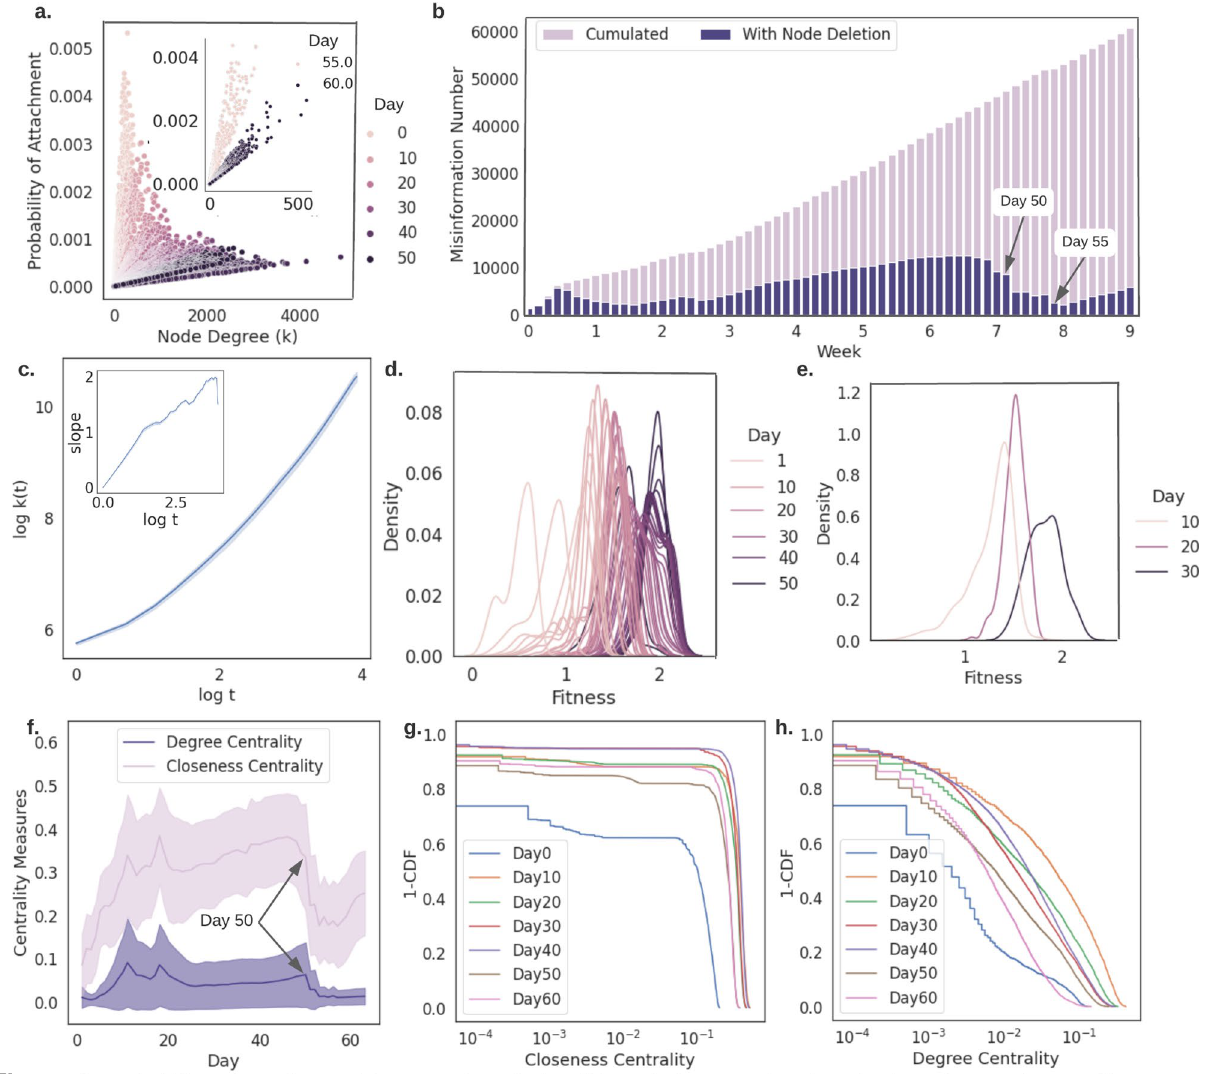
Figure 4. Probability of attachment ( a ), network evolution ( b ), node fitness estimations ( c-e ), and network centrality measures ( f-h ) of misinformation networks with deletion mechanism. ( a ) The probability of attachment is linearly correlated with the node degree. From day 0 to day 50, the probability of attachment for nodes with same degrees is decreasing. This observation shows that the rich get richer effect becomes weaker. Then the probability of attachment from day 55 appears to be similar as in day 0 to 10. ( b ) Misinformation network size (node) evolution comparison. Different from classical network expansion method (as shown in light purple bars), our realistic network construction method with node deletion mechanism appears to be sensitive to public attention/topic shifting. ( c ) The evolution of 158 surviving nodes S [ 0,50 ] ’s accumulated degrees, k ( t ) over time. Node fitness is approximated as the slope and it increases from day 0 until day 49 as shown in in-plot. This finding is distinct from the frequently used time-invariant fitness assumption in complex network evolution models. Hence, we further inspect the fitness (growth exponent) distribution of S [ 0,50 ] as shown in ( d ). These distributions do not have heavy tail property, which indicates that there is no clear sign of fit get richer phenomenon. Moreover, to compare with fitness distribution we observed in Fig. 3 more clearly, in ( e ), we inspect the fitness distributions of S [ 0,10 ] , S [ 0,20 ] , and S [ 0,30 ] , which correspond to the misinformation network (with node deletion) on day 10, 20, and 30. We find that these non-heavy tail distributions again indicate that there is no clear sign of fit get richer effect. ( f–h ) Network centrality measures. Degree centrality first increases then becomes stable until day 50. This confirms that the rich get richer effect is weak. The closeness is slightly increasing with regard to time and indicates that the newly added nodes lower the average of the shortest path . Nodes with low fitness are deleted in the process, and nodes that survived must maintain high fitness to be close to new nodes. This matches the observations in ( b–c